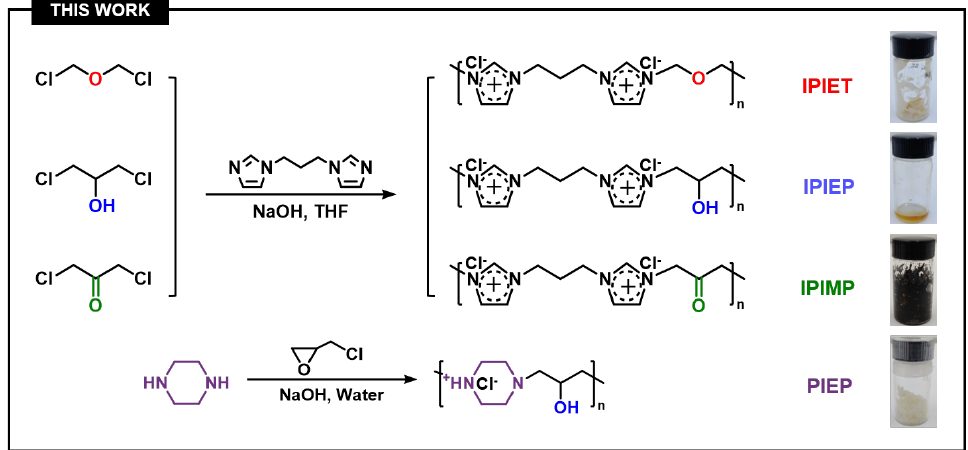
Figure 11. The synthesis of oligomers with varied donor units.